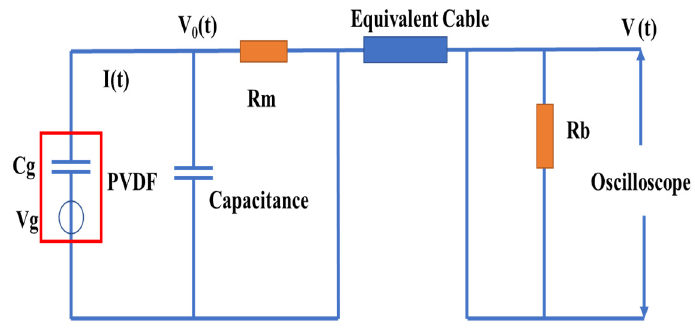
Figure 2. Pictures of the REB device. Test circuit of PVDF charge mode.